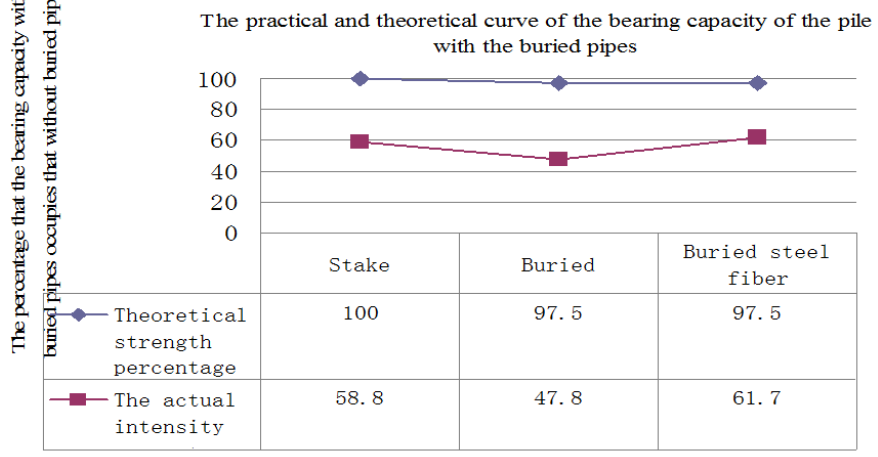
Figure 15: Comparison between the test of the pile with buried pipes and the its theoretical